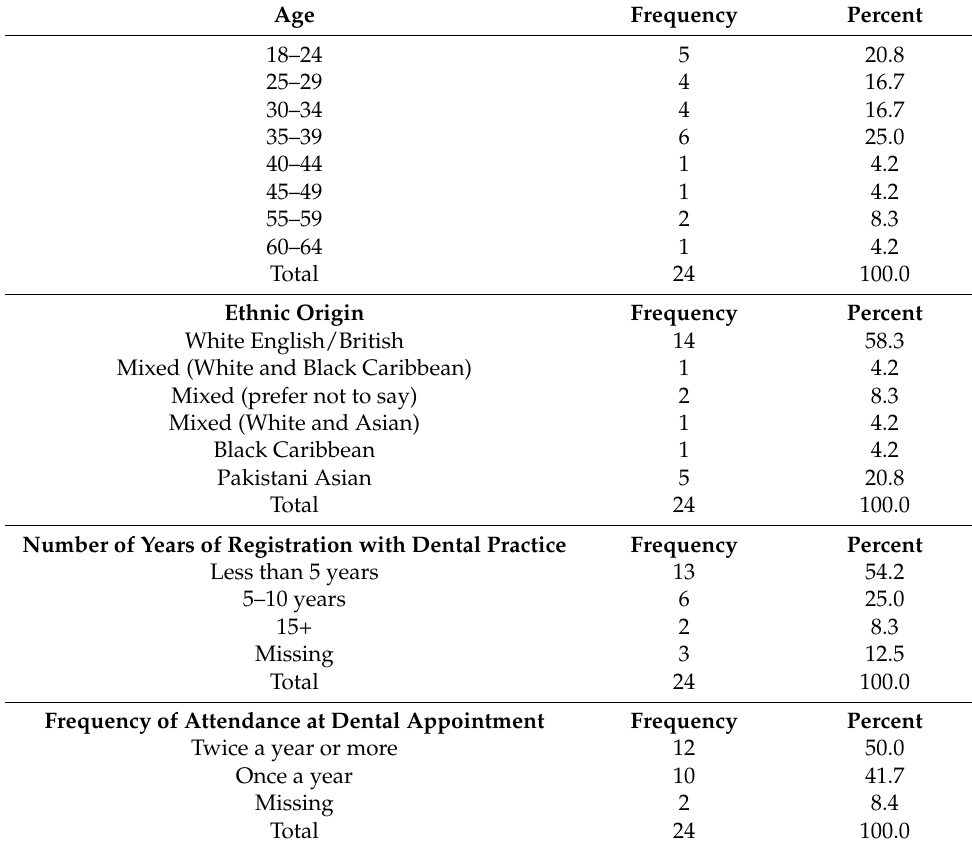
Table 1. Characteristics of Study